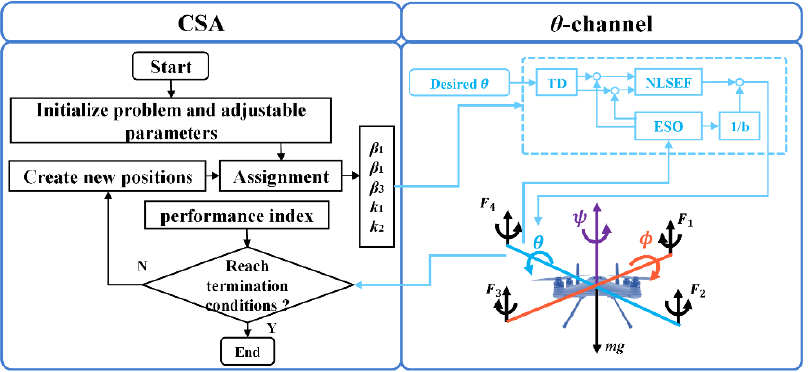
Figure 3. The schematic diagram of the improved CSA with optimized θ-channel active disturbance rejection controller.